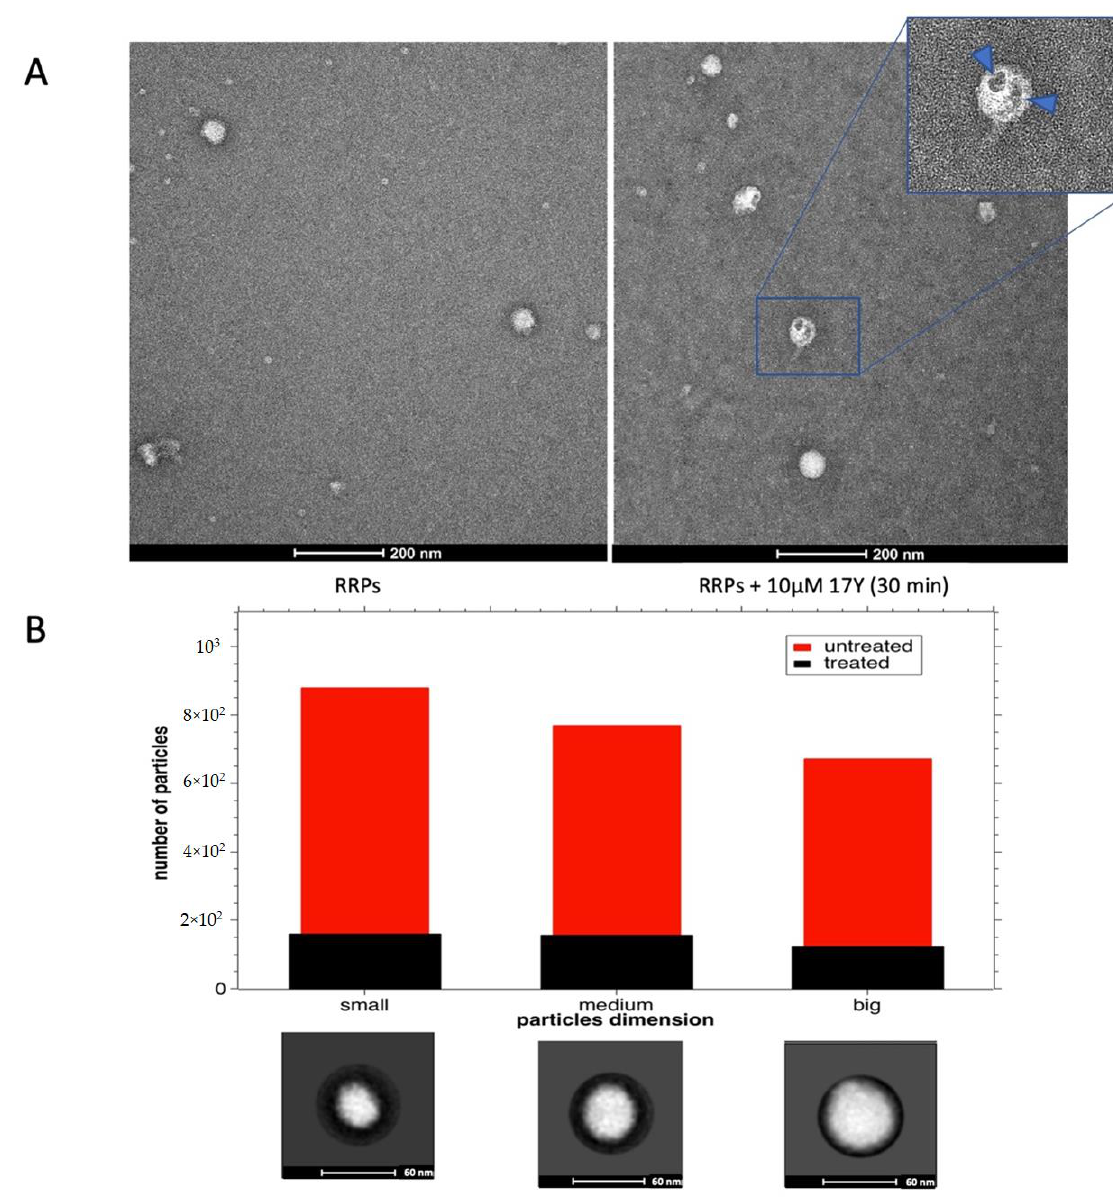
Figure 3. Negative staining analysis of WNV RRPs treated/not treated with 17Y. ( A ) Negative staining of WNV RRPs (left) or treated with 10 µ M 17Y for 30 min (right). Close-up view of a particle with holes indicated by blue arrows. ( B ) Number of RRP particles not exposed (red bars) or exposed to 17Y (black bars) from 158 and 190 micrographs, respectively. The particles were selected using 2D classification and representative 2D classes are reported below to show each dimension (black circle diameter = 60 nm): small (D~32 nm), medium (D~46 nm) and big (D~56 nm), corresponding to empty, mature, and immature virions, respectively. The error bars represent an assumed error (20%) for the number of particles due to the selection